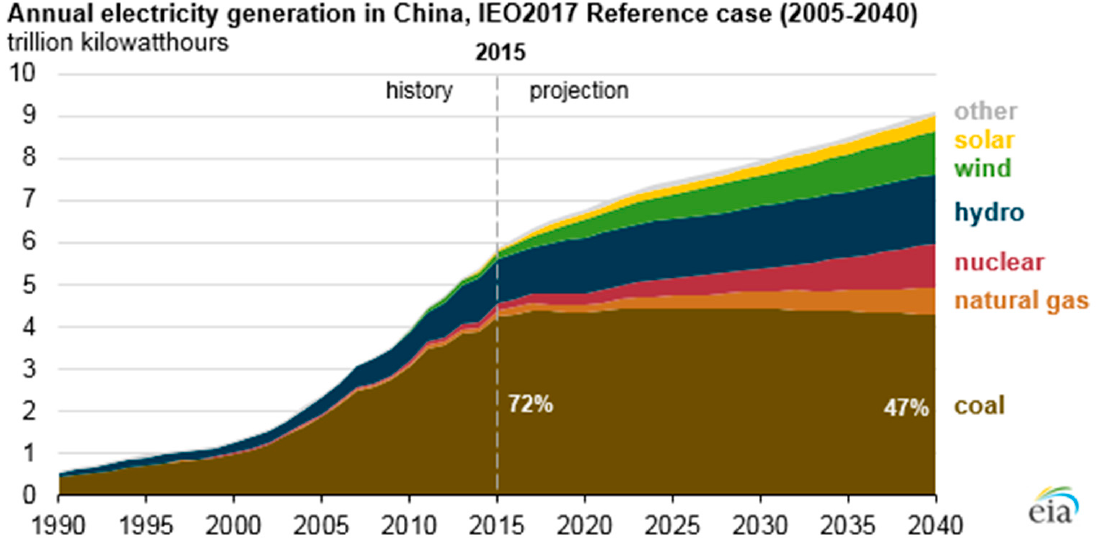
Figure 6. Annual electricity generation in China. Source: U.S. Energy Information Administration, International Energy Outlook (Sept 2017) [66].